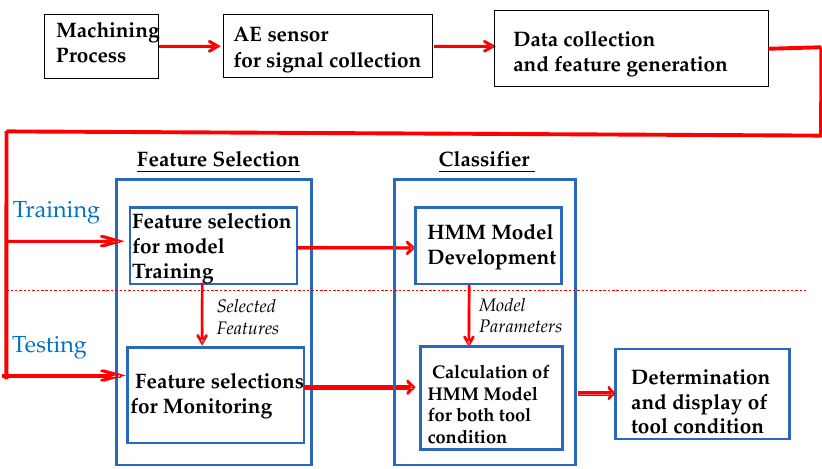
Figure 1. Schematic of tool condition monitoring.